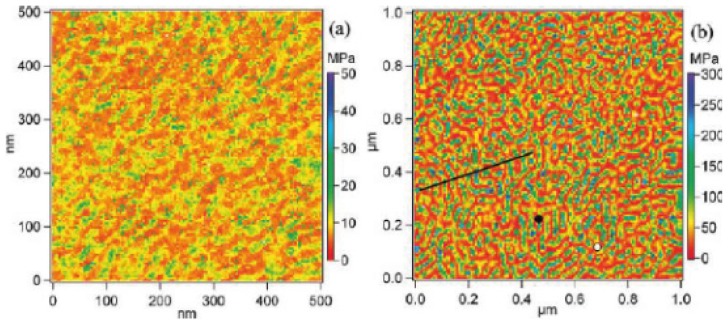
Force imaging spectroscopy—Young’s modulus maps of (a) SEBS (10/80/10) and (b) SEBS (21/58/21) (Reprinted with permission from [119] (© 2010, American Chemical Society)).